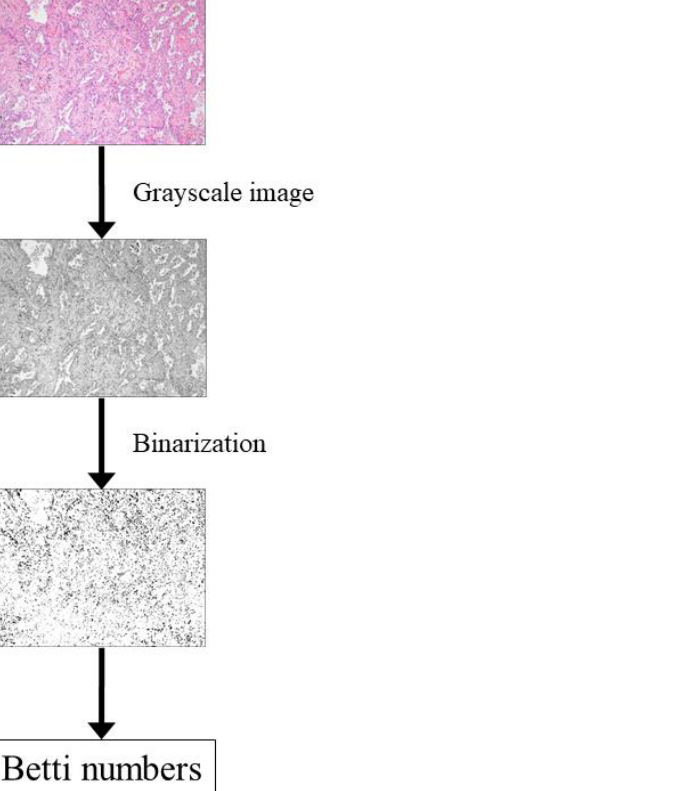
Figure 4. Outline of the process of calculating Betti numbers.